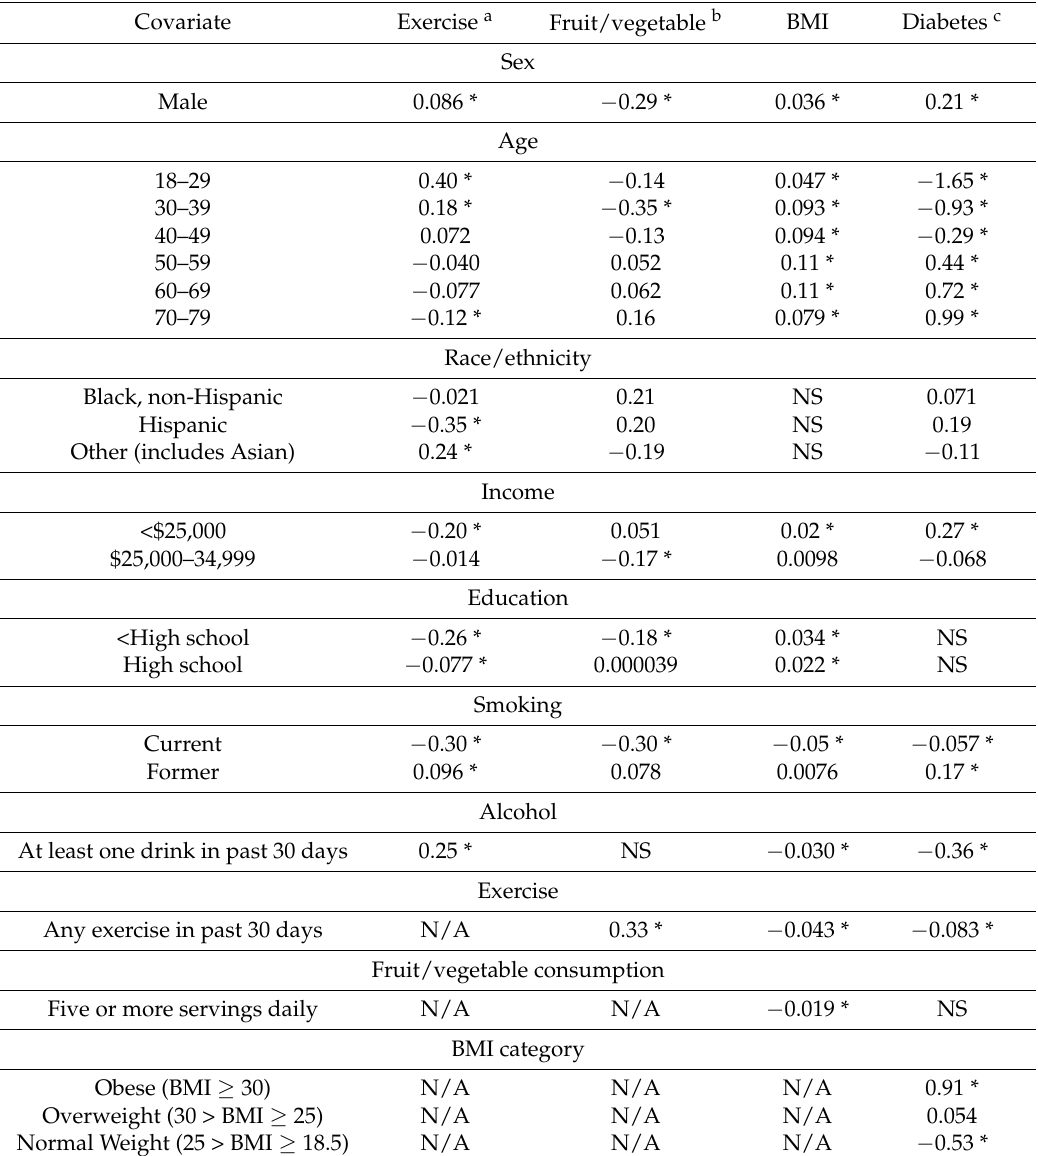
Table 1. Multivariable regression coefficients for exercise, fruit and vegetable consumption, body mass index (BMI), and diabetes constructed from Behavioral Risk Factor Surveillance System (BRFSS) data for Bristol County, Massachusetts (2005–2010). BMI model is a linear regression, and other models are logistic regressions. Full models with standard errors are in Table